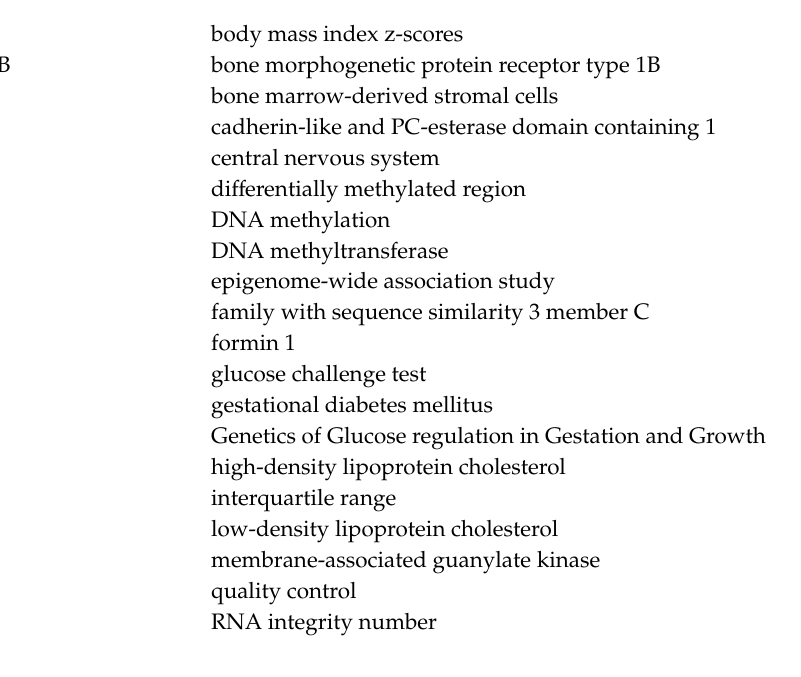
clean-up, Figure S2: QQ-plot for the association between placental methylome and childhood adiposity, Figure S3: Regional association plot and correlation heatmap of CpGs located near cg22593959 from the CpG-by-CpG analysis, Figure S4: Regional plot and correlation heatmap of CpGs located near cg22436429 from the CpG-by-CpG analysis, Figure S5: Regional plot and correlation heatmap of CpGs located in the FMN1 gene locus from the regional analysis, Figure S6: Regional plot and correlation heatmap of CpGs located in the MAGI2 gene locus from the regional analysis, Figure S7: Regional plot and correlation heatmap of CpGs located in the SKAP2 gene locus from the regional analysis, Figure S8: Regional plot and correlation heatmap of CpGs located in the BMPR1B gene locus from the regional analysis, Table S1: Characteristics of the mothers and children from 3D